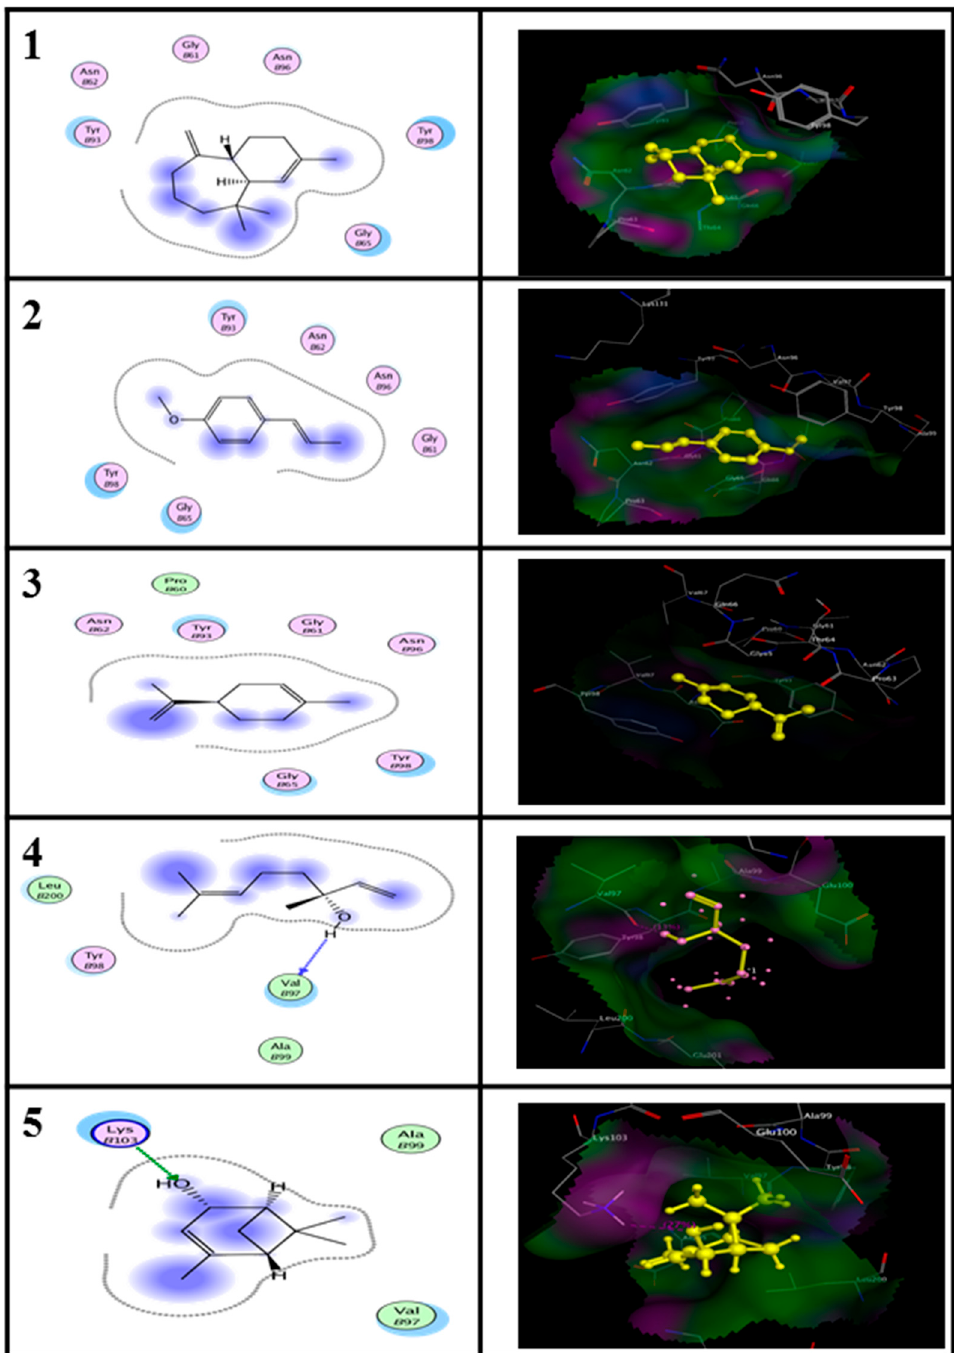
Figure 4. Molecular docking of essential oil (EO) and nanoemulsion (NE) ligands of Pimpinella anisum with homology modeled Alanine aminotransferase (ALT) of Tribolium castaneum created by Molecular Operating Environment (MOE) program.